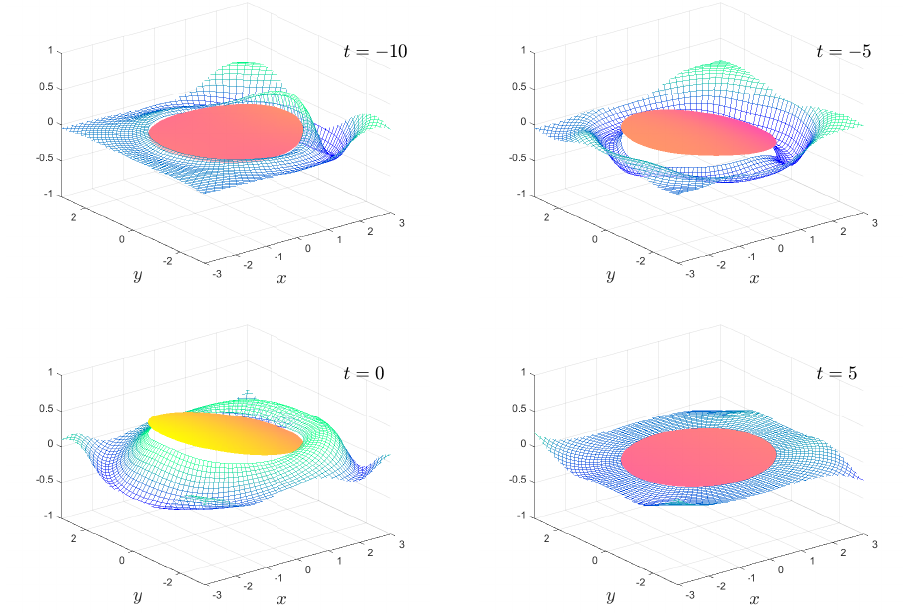
Figure 6. The time-dependent motion β = 1 × 10 − 1 , γ = 0, h = 1 and a = 2 for the times shown. The full animation can be found in movie